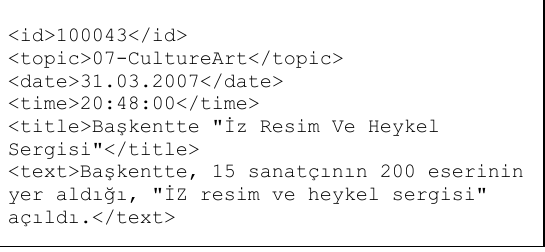
Fig. 1. Sample File Content